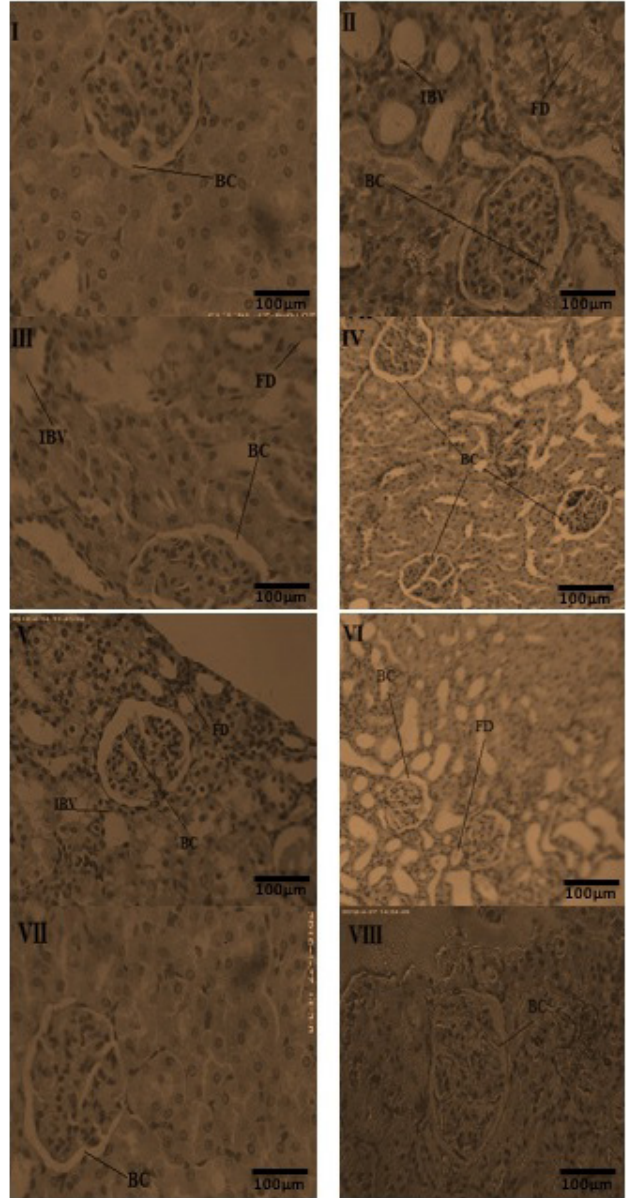
FIGURE 6 - Histology of the kidney. (I) normal control, (II) diabetic control, (III) HNC, (IV) HNN, (V) HNE, (VI) HNA, (VII) lupeol and (VIII) glibenclamide. Samples were magnified at 40X and “BC” is bowmen capsule, “IBV” is interstitial blood vessels and “FD” is fatty